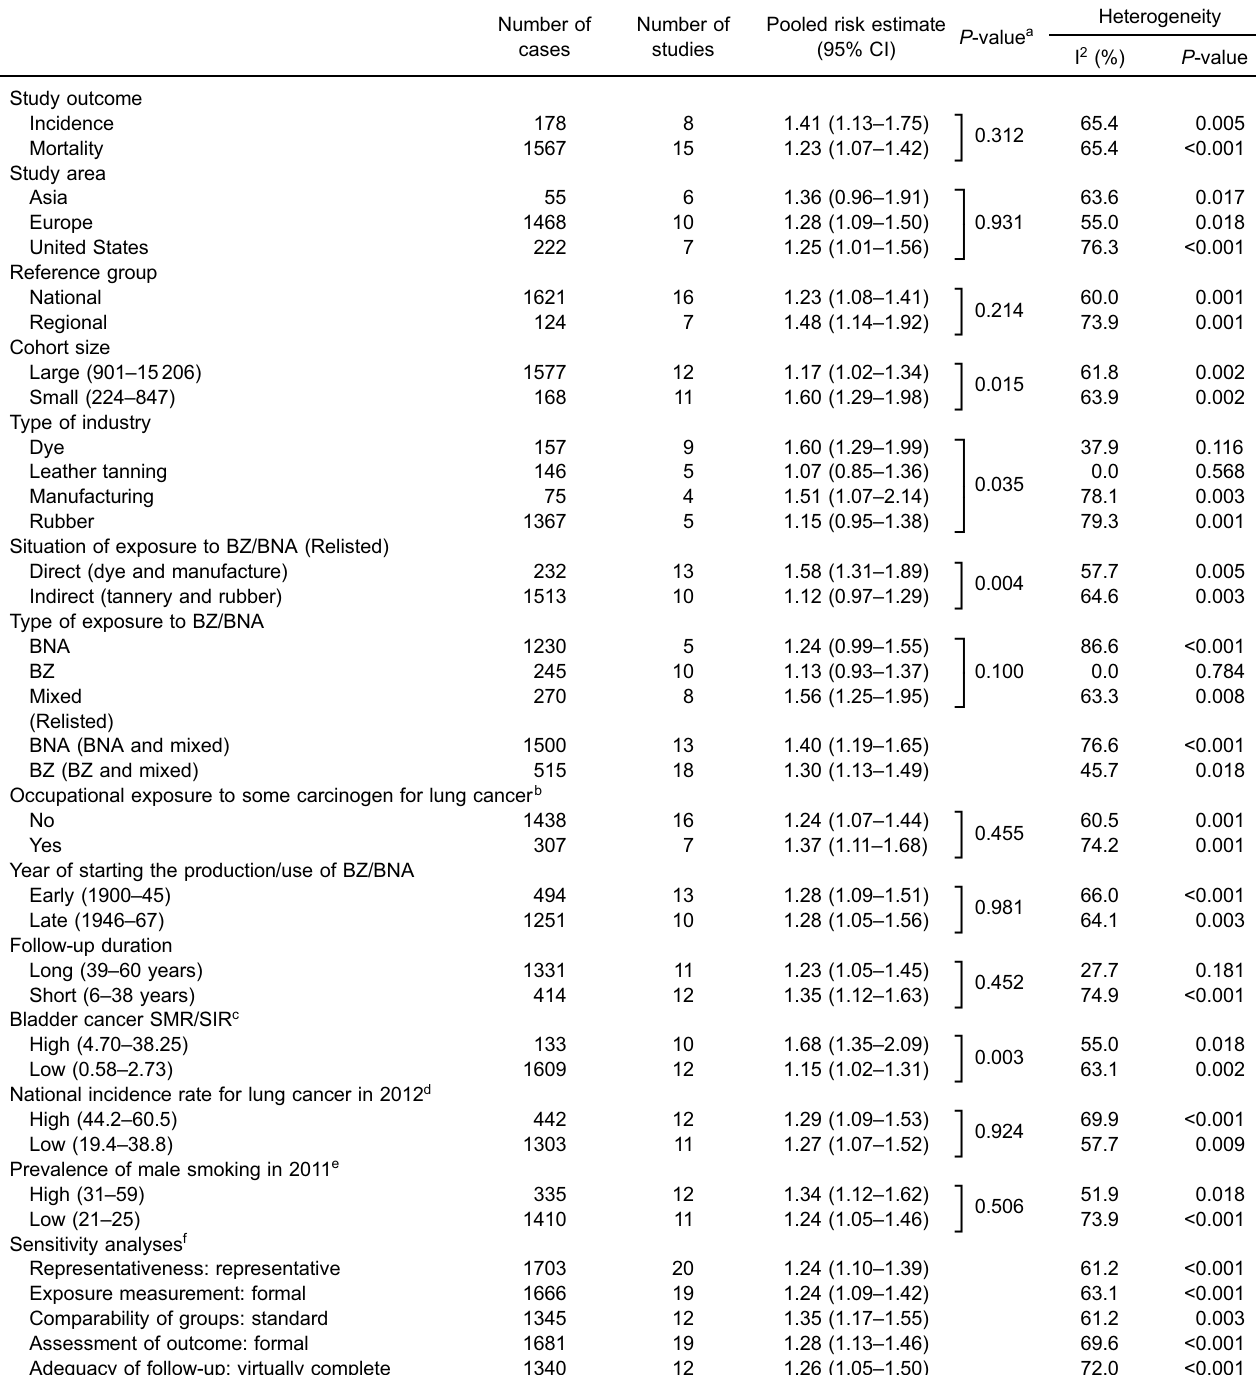
Table 2. Pooled risk estimates resulting from subgroup analyses and sensitivity analyses